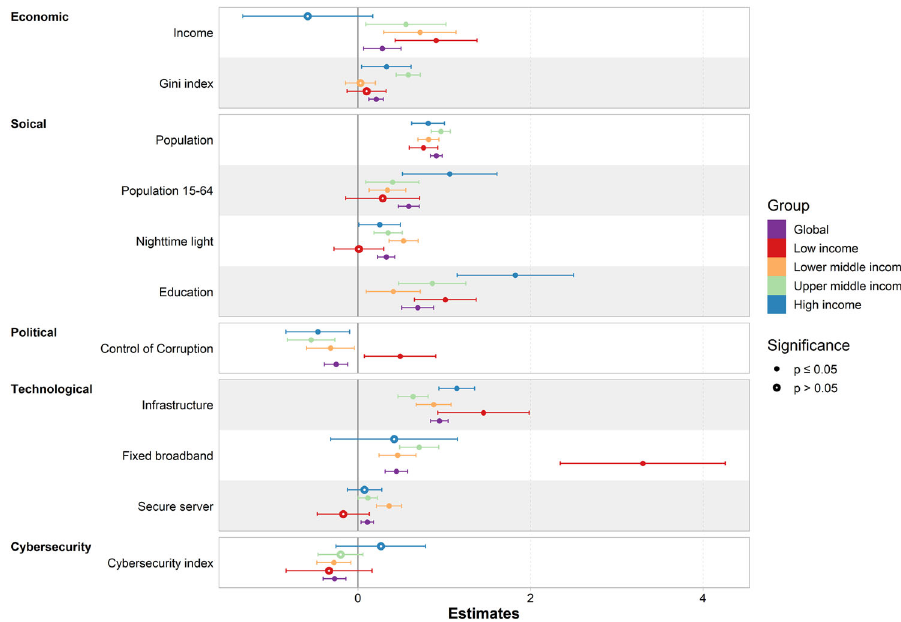
Fig. 4 Effects of predictor variables on cybercrime. The coef fi cient values are represented as dots, signi fi cant variables are represented as fi lled dots, nonsigni fi cant variables are represented as hollow dots, and bars represent 95%